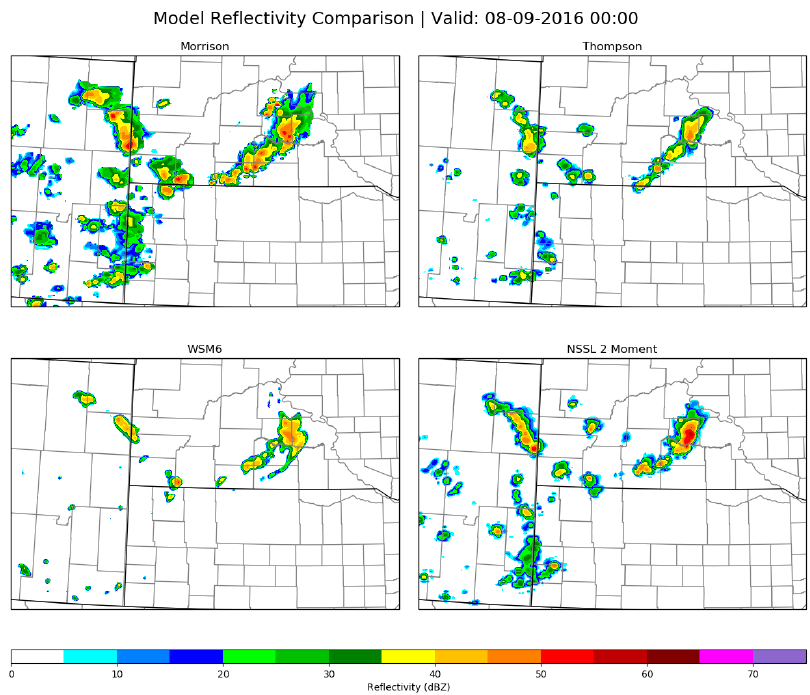
Figure 10. As in Figure 6, but for a non-MCS event on 8 August 2016, four hours after convective initiation. Images are 12-h WRF forecasts valid at 0000 UTC.